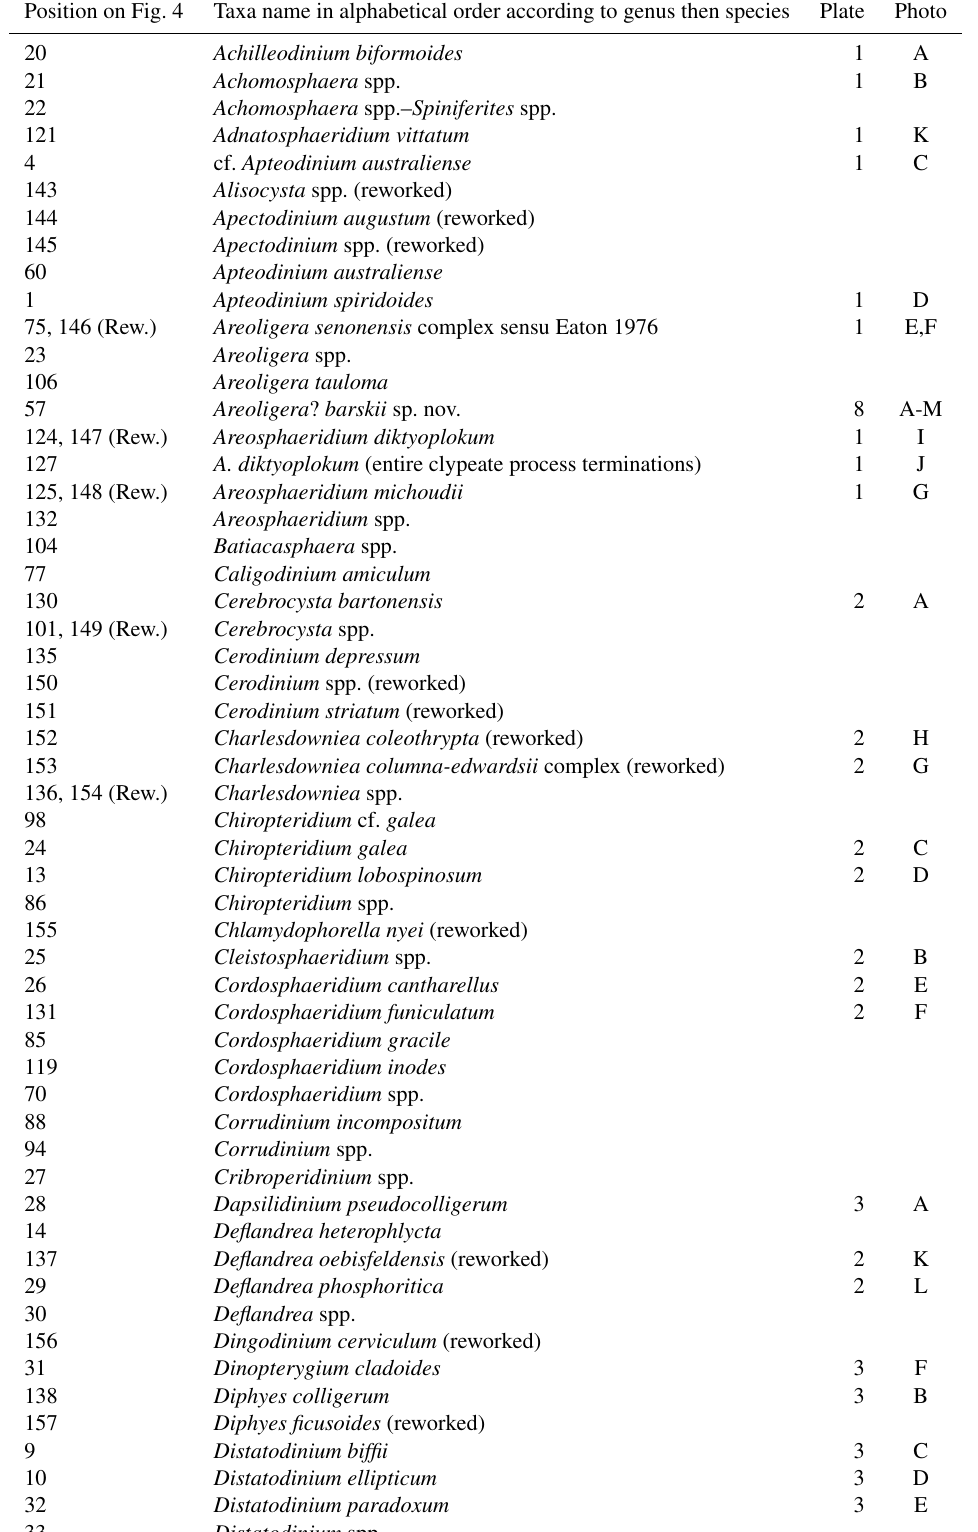
Table 1. Alphabetical list of all identified dinocyst taxa identified in the 11/10-1 well. The first column refers to the position of the taxon in Fig. 3. The right column includes a key for all photographed specimens which are shown in Plates 1 to 8. Rew. stands for reworked. Position on Fig.